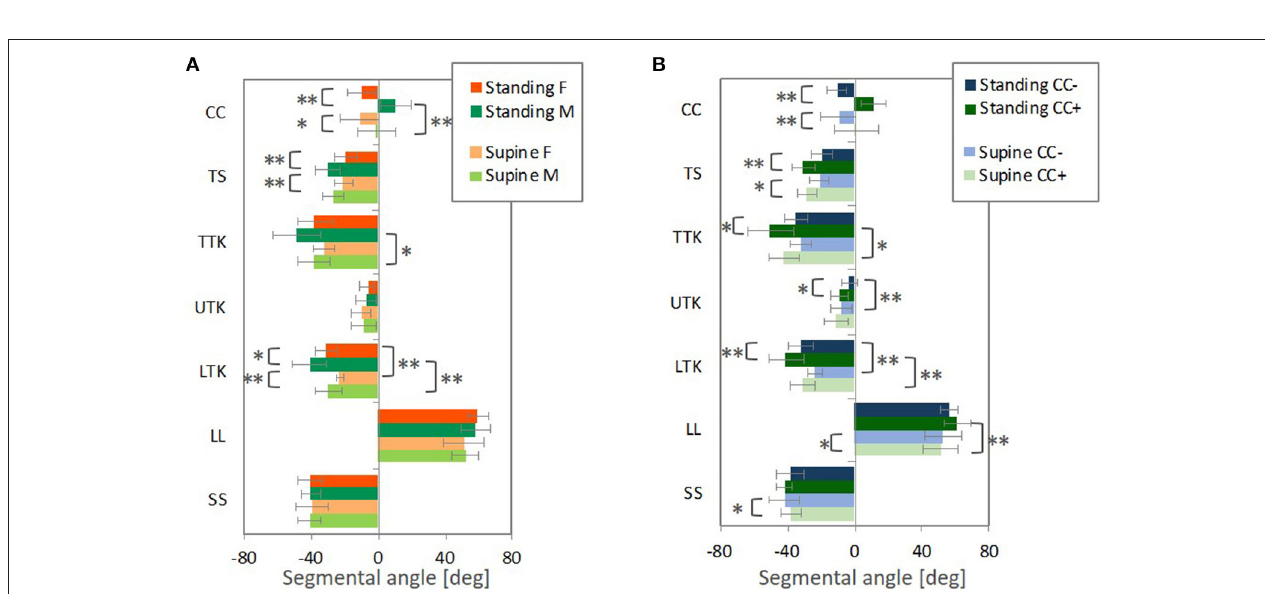
FIGURE 10 | The average segmental angles with standard deviation and p -value from t -test (** < 0.05, * < 0.1), (A) comparing male and female subjects (M and F) and (B) the negative CC (CC − ) and positive CC (CC + ). Figures in legends indicate the seat back angles from the vertical line.